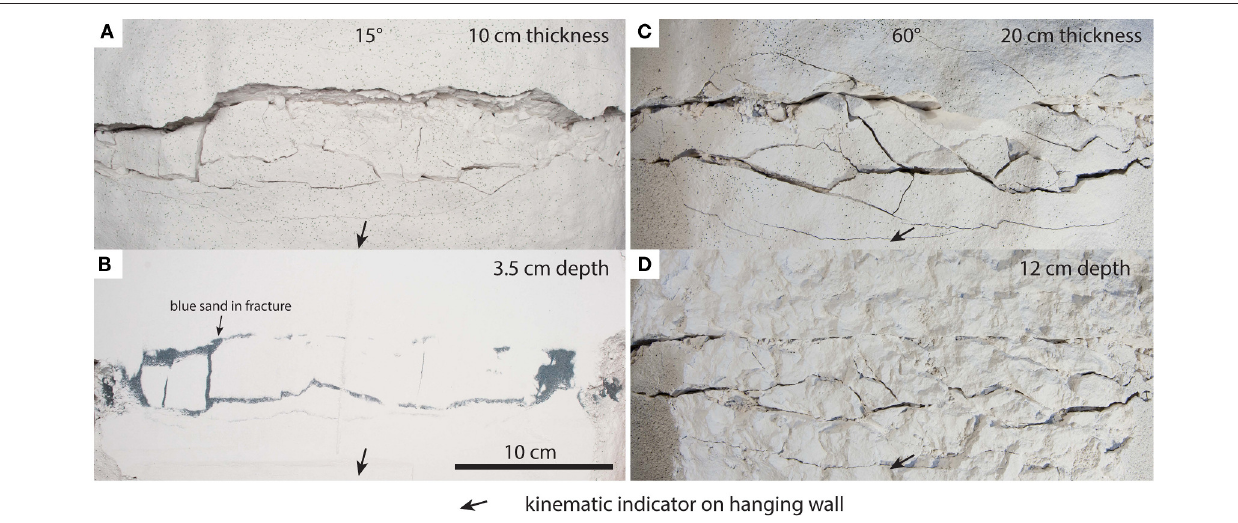
FIGURE 6 | Excavated experiments. Two excavation techniques have been applied to visualize open fractures at depth. First, open fractures were filled with dyed sand, and the experiment was sliced from top to bottom. (A) Top view on surface structures of experiment with 10cm powder thickness and 15 ◦ obliquity. Down-thrown block at bottom, arrows indicate direction of movement. (B) Excavated experiment. Blue sand filled the open fractures at depth. At 3.5cm wide open fractures exist at depth. Tilted blocks at the hangingwall collapsed and reduce area fraction of open gaps at the main fault. The antithetic fault remains open. (C) Top view of powder experiment with 20cm powder thickness and 60 ◦ obliquity. (D) Surface excavated with vacuum cleaner. Vacuum cleaning results in more rugged surface as opposed to slicing, but small open fractures are unencumbered by the excavation process. Similar to (B) , the area fraction of open gaps is larger at the antithetic fault, as the main fault is filled with debris of collapsing tilted blocks.